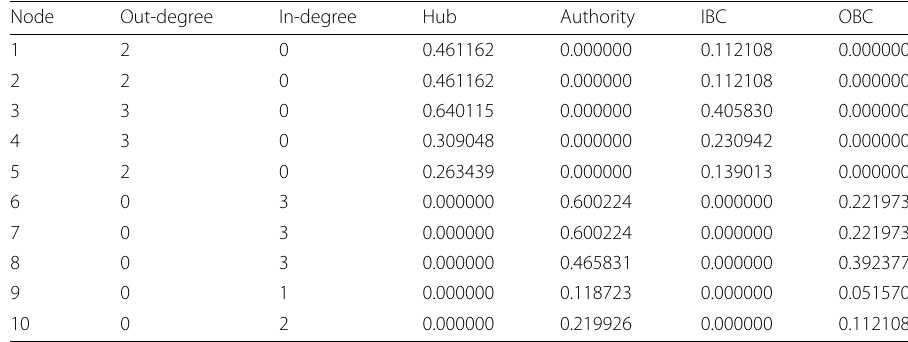
Table 1 Centrality measures for the toy network in Fig. 5b Node Out-degree In-degree Hub